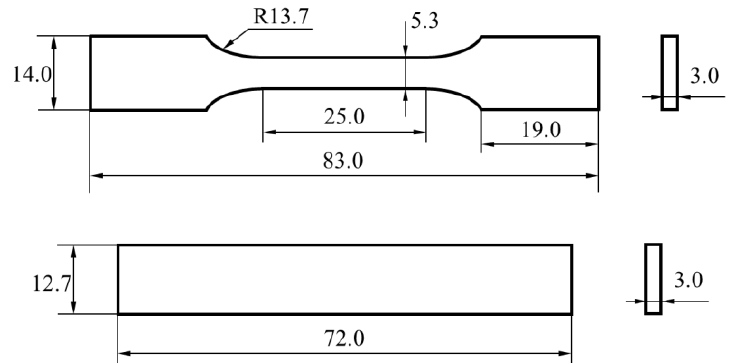
Figure 2. Tensile and bending specimen (mm).